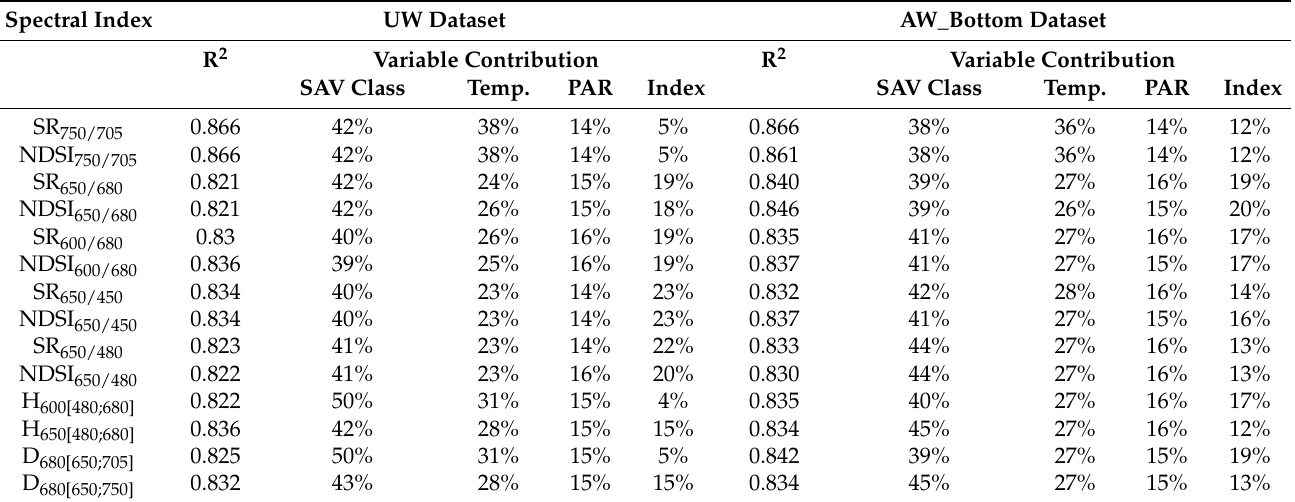
Table 4. The predictive power of models (R 2 ) and the relative contribution of different variable to the models’ total variable explained (%) separately for UW and AW_bottom